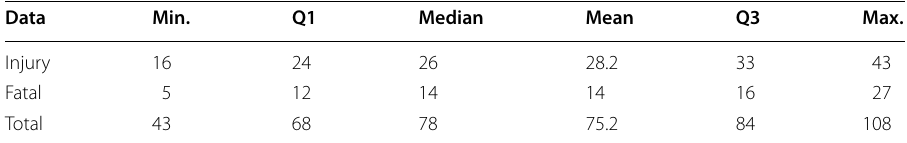
Table 1 Summary statistics of road traffic accidents